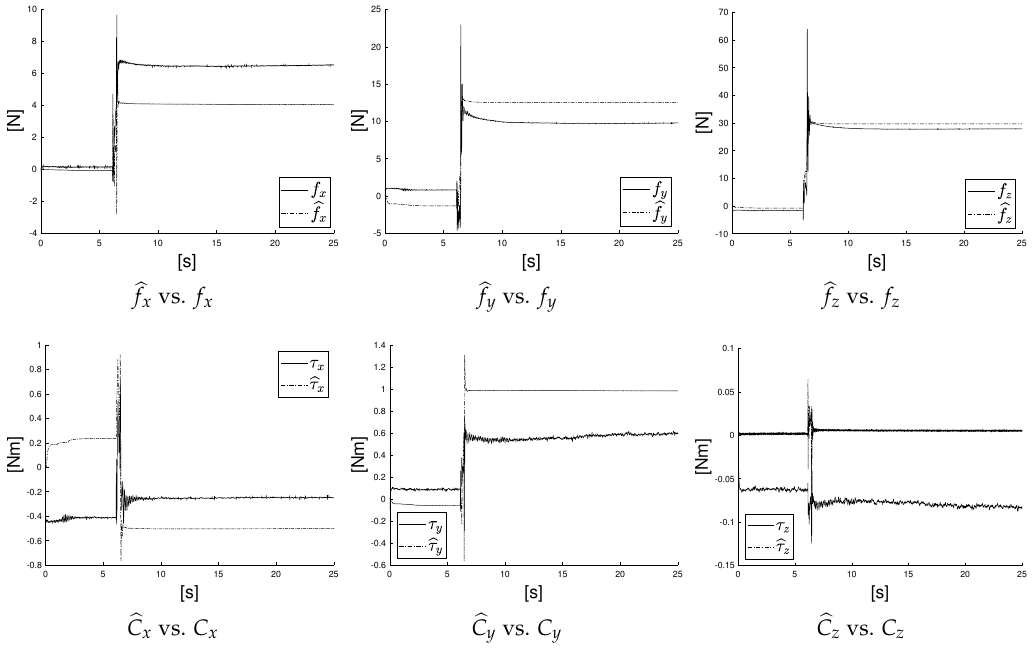
Figure 12. Estimated interaction forces (cid:98) f and torques (cid:98) C (continuous line) vs. measured interaction forces f and torques C (dashed line) for the #2 experimental